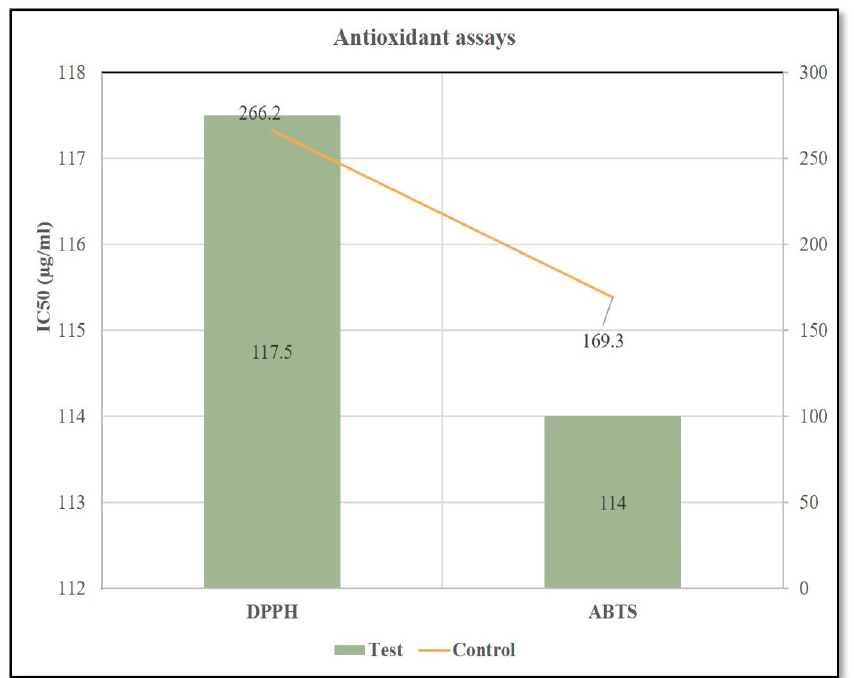
Figure 10. ABTS and DPPH radical scavenging activity methanolic extracts obtained from untreated chickpea plants and chickpea plants treated with bacterial cells of Streptomyces sp. strain DBT34. Cells were applied to the soil and plants were grown for 4 weeks prior to determining their antioxidant potential.